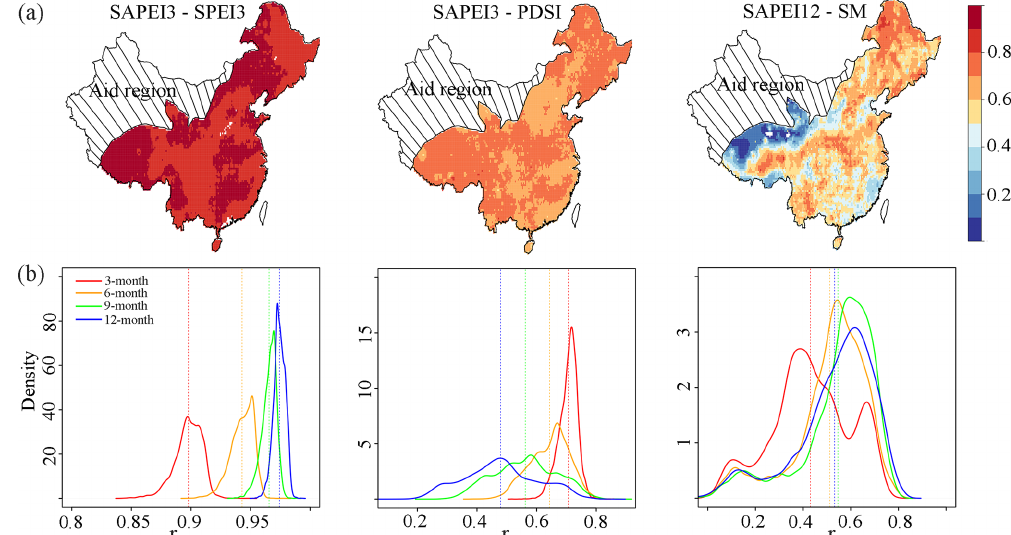
Figure 4. (a) The spatial pattern of the correlations between the monthly SAPEI and SPEI/PDSI and between the daily SAPEI and soil moisture (SM). (b) The density plot for the correlation coefficients between the SAPEI and SPEI/PDSI/SM. The monthly SAPEI is computed by averaging the daily values in each month.